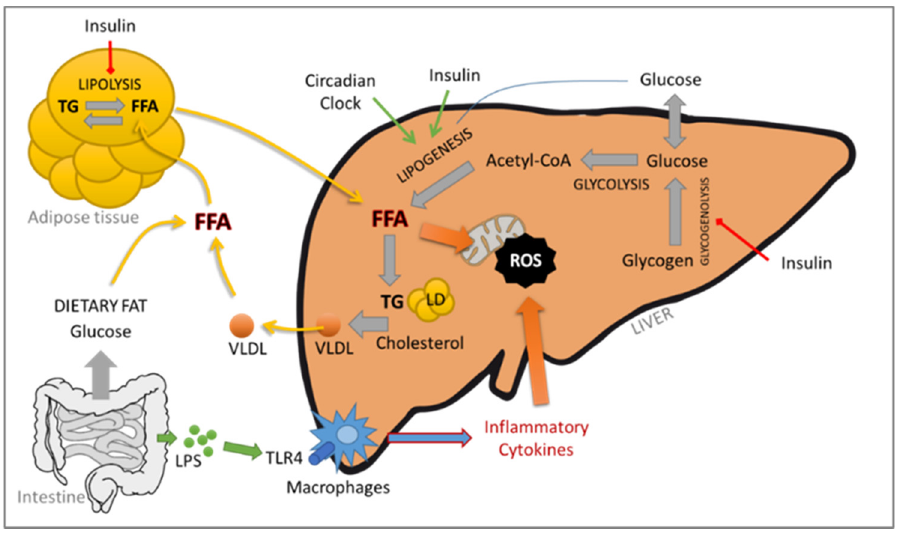
Figure 1. Schematic representation of the molecular dynamism in the “multiple parallel hits hy-